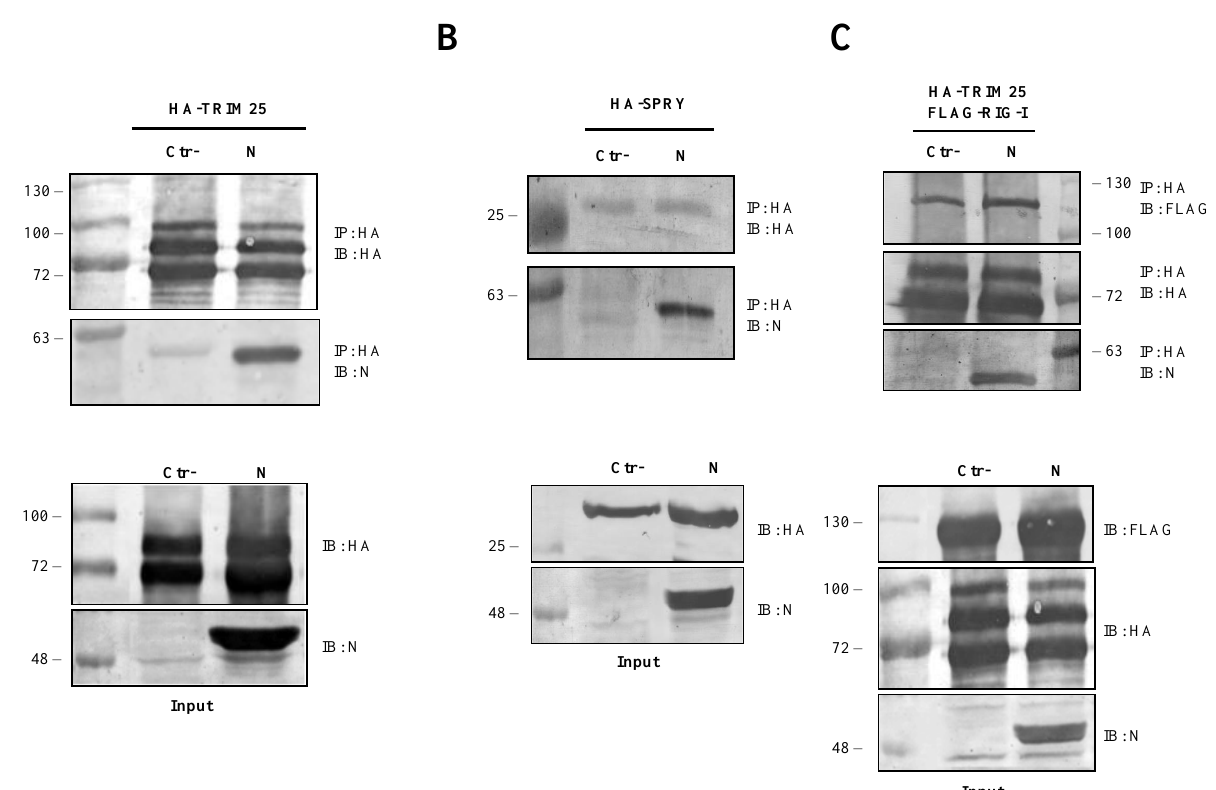
Figure 4. SARS-CoV-2 N protein is an interacting partner of TRIM25. The ability of SARS-CoV-2 N protein to interact with TRIM25 and RIG-I was determined by co-immunoprecipitation (Co-IP) on lysates of transfected Lenti-X 293T cells. ( A ) The formation of a stable immune complex was detected when TRIM25 was transiently over-expressed along with the N protein following Co-IP with anti-HA. ( B ) The N viral protein presented affinity with the SPRY domain of TRIM25 because the viral protein was detected in the anti-HA Co-IP performed on lysates of Lenti-X 293T cells expressing HA-SPRY, alone or in combination with the N protein. ( C ) The capability of SARS-CoV-2 N protein to disturb the RIG-I-TRIM25 interaction was then investigated by Co-IP on lysates of Lenti-X 293T cells simultaneously expressing RIG-I, TRIM25 and N. The interaction between RIG-I and TRIM25 was not affected by the presence of the viral protein. Indeed, their interaction was detected as co-immunoprecipitating with anti-HA antibody in the samples in which the N protein was either present or absent. Blots are representative of ( n = 3) independent experiments. Fifty micrograms of WCLs were loaded on SDS-PAGE and immunostained as protein expression